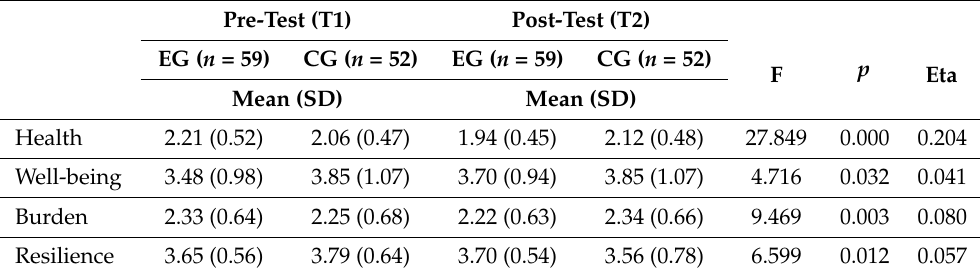
Table 2. Descriptive analysis of health, well-being, resilience, burden and resilience in Time 1 and Time 2 by experimental group (EG) and control group